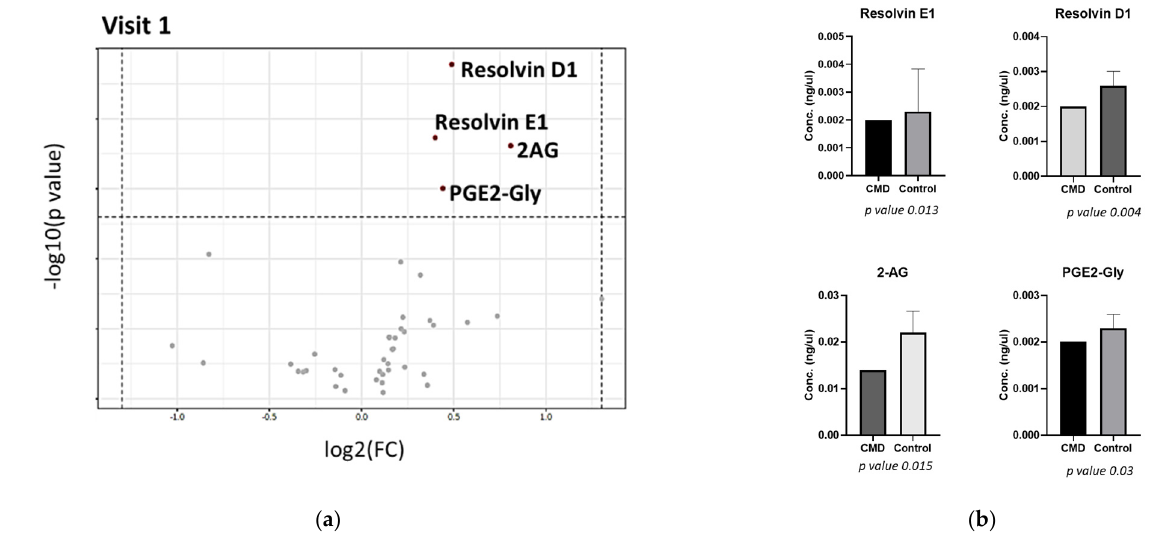
Figure 6. Dysregulation of lipids in early pregnancy. ( a ) Volcano plot showing increased concentra- tions of Resolvin E1, Resolvin D1, 2-AG, and PGE2-Gly in serum of control patients compared to the CMD group. ( b ) Box plots demonstrating statistically significant increases of RvE1, RvD1, 2-AG, and PGE2-Gly in control group compared to CMD group.